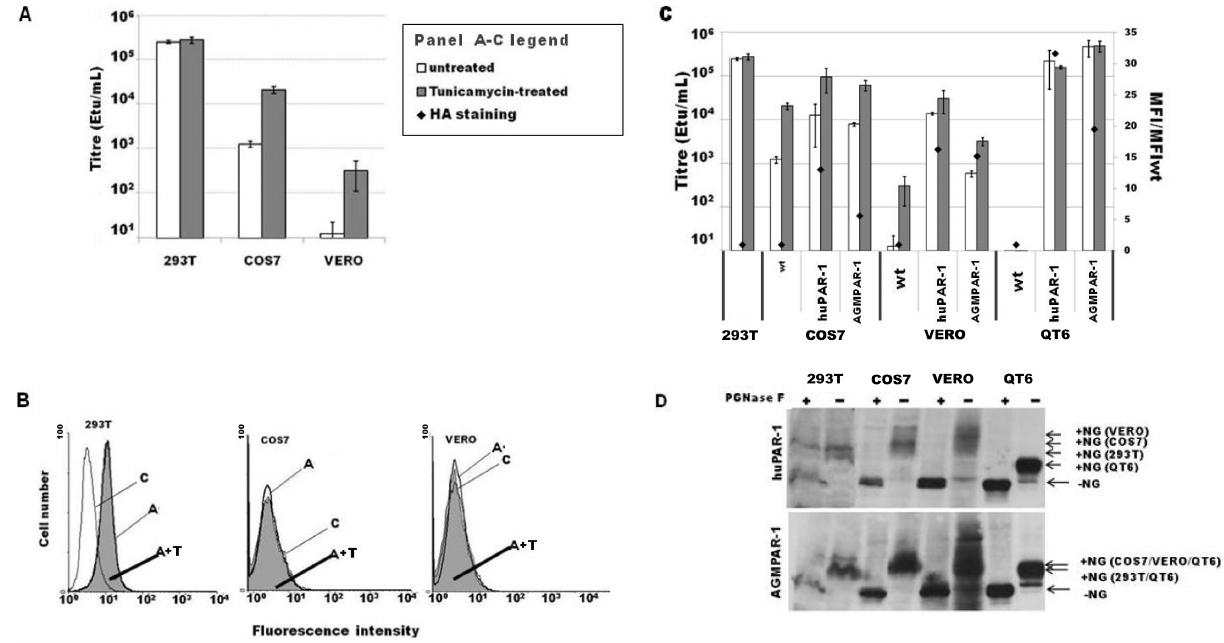
Figure 4. Effect of tunicamycin treatment on PERV infection and analysis of N-glycosylation of PERV-A receptors. Cells were treated for 16 hrs with tunicamycin at the final concentration of 100 ng/mL (293T cells), 200 ng/mL (COS7 and VERO cells) or 25 ng/mL (QT6 cells). A ) Tunicamycin-treated (grey) or untreated (white) cells were infected with serial dilution of EGFP(PERV) and the titers calculated 72 hrs later by flow cytometry analysis. Histograms represent the average of four independent experiments ( 6 SEM). B ) Cells were incubated with 100 ng in 0.5 mL of soluble PERV-A360 Env or PERV-C360 Env and Env binding was detected using a FITC-conjugated anti-rabbit IgG antibody and flow cytometry analysis. A representative set of results of three independent experiments are shown for tunicamycin-treated cells with PERV-A360 Env (A + T), untreated cells with PERV-A360 Env (A), untreated cells with PERV-C360 Env (C) is shown. Almost identical histograms were obtained for PERV-C360 binding with and without tunicamycin treatment. C ) Quail QT6, AGM COS7 and VERO cells were stably transduced with MLV-vectors carrying HA- tagged huPAR-1 or AGMPAR-1. More than 98% of the cells were positive for anti-HA antibody staining (data not shown). Mean fluorescence intensity (MFI) of anti-HA staining for each population was normalised to the MFI of the wild type cells (black diamond). Tunicamycin-treated (grey) or untreated (white) cells were infected with serial dilutions of EGFP(PERV) and the titers determined by EGFP expression monitored by flow cytometry analysis. Histograms represent the average of two independent experiments ( 6 SEM). D ) HA-tagged huPAR-1 (upper panel) and AGMPAR-1 (bottom panel) transduced cells were lysed in RIPA buffer and treated ( + ) or not ( 2 ) with PNGase F. Proteins were separated in a 10% SDS-PAGE and immunoblotted using an anti-HA antibody. The N-glycosylated ( + NG) and the de-glycosylated ( 2 NG) forms are